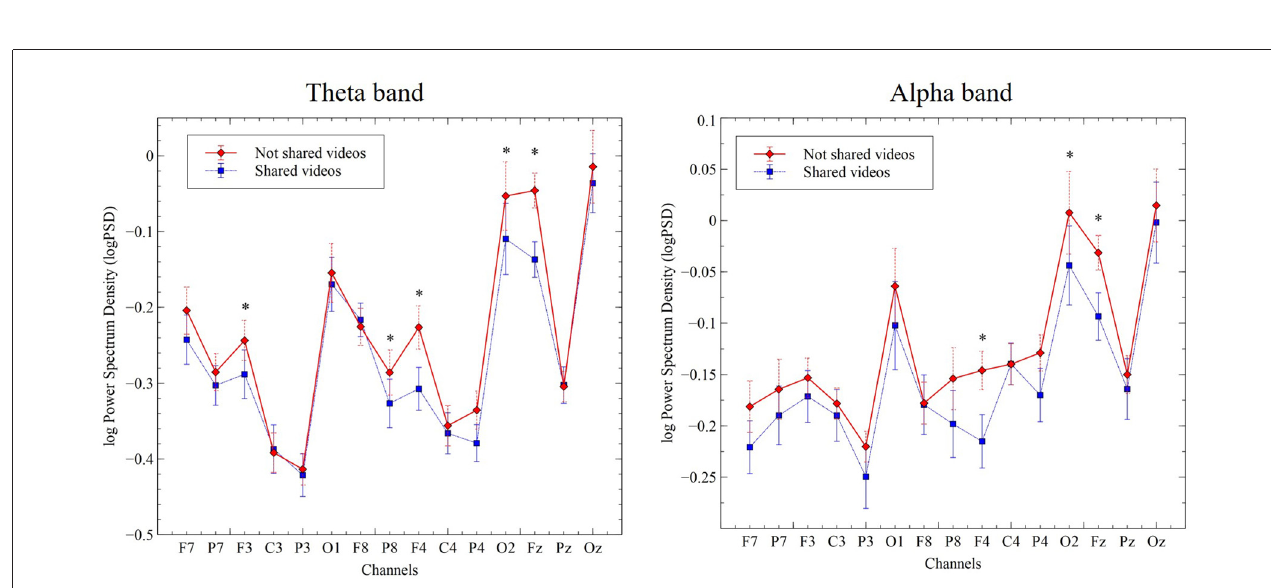
FIGURE 3 | Change in log power spectral density (PSD; µ V 2 /Hz) for the theta-band (4–8 Hz, left panel) and alpha-band (8–12 Hz, right panel) in the indicated channel clusters during viewing of S and N-S videos. Data represent the mean ± SEM. ∗ p ≤ 0.05.